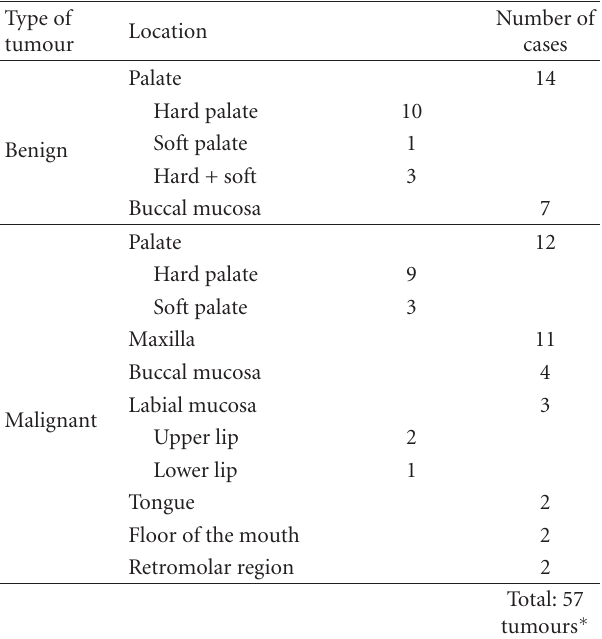
Figure 3: Adenoid cystic carcinoma of the left maxilla. Table 1: Tumour